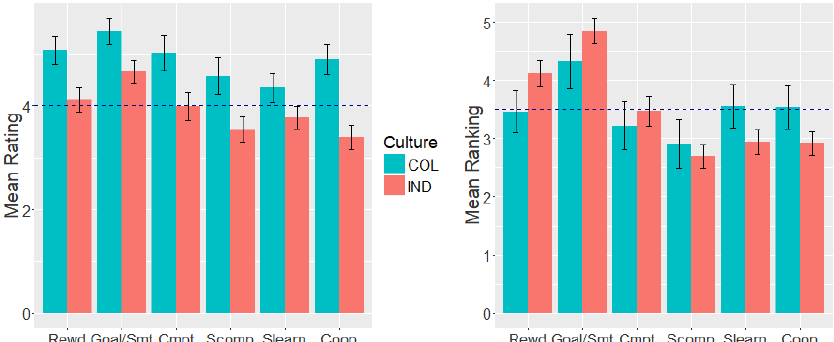
Figure 3. Culture-based mean rating (left) and ranking (right) of persuasive features. Crossbar indicates the neutral value on the 1–7 Likert scale and the mean value on the 1–6 ranking scale; REWD = Reward, GOAL/SMT = Goal-Setting/Self-Monitoring, CMPT = Competition, SCOMP = Social Comparison, SLEARN = Social Learning, COOP = Cooperation; COL = Collectivist culture, IND = Individualist culture .